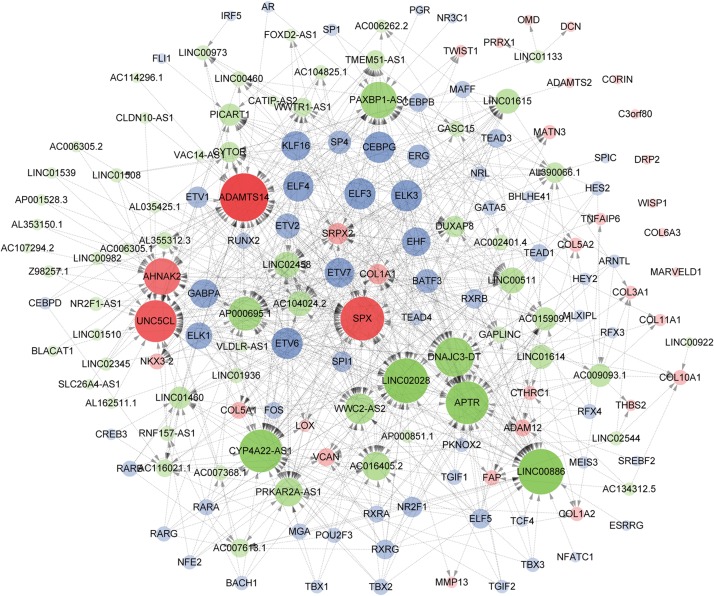
Construction of the TF/lncRNA/mRNA regulatory network. Hub genes, TFs, and lncRNAs are denoted in red, blue, and green, respectively. The point size indicates the node edgecount and the arrow represents regulatory effect.